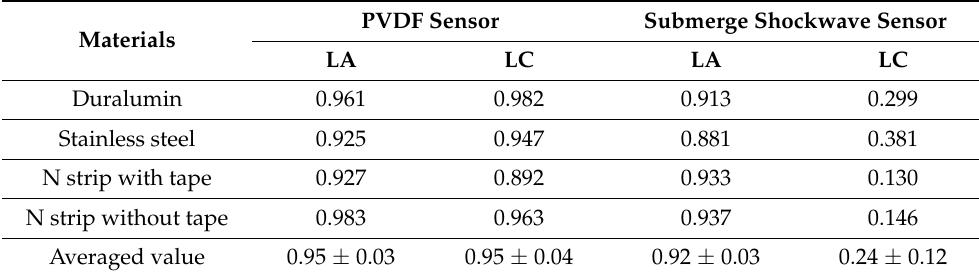
Table 1. Correlation coefficient between the arc height and output signal from the